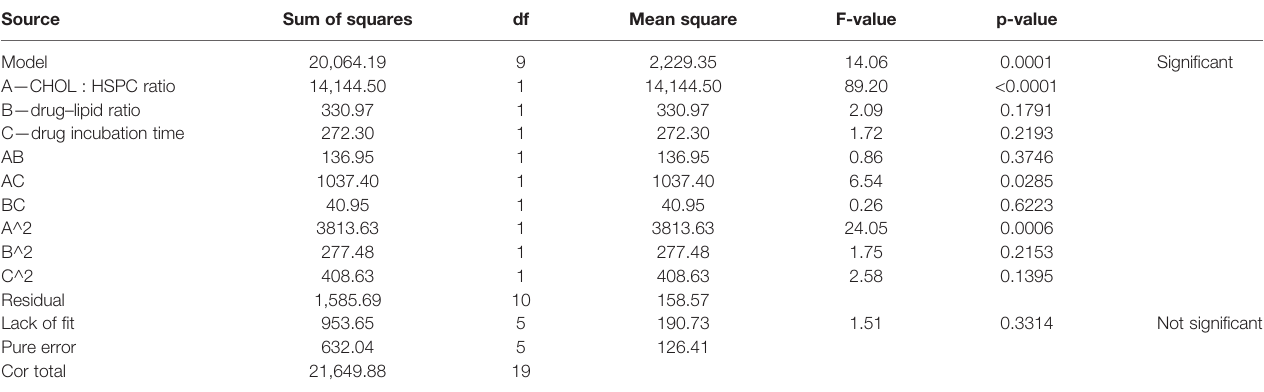
TABLE 5 | Results of variance analysis of size (Y1).